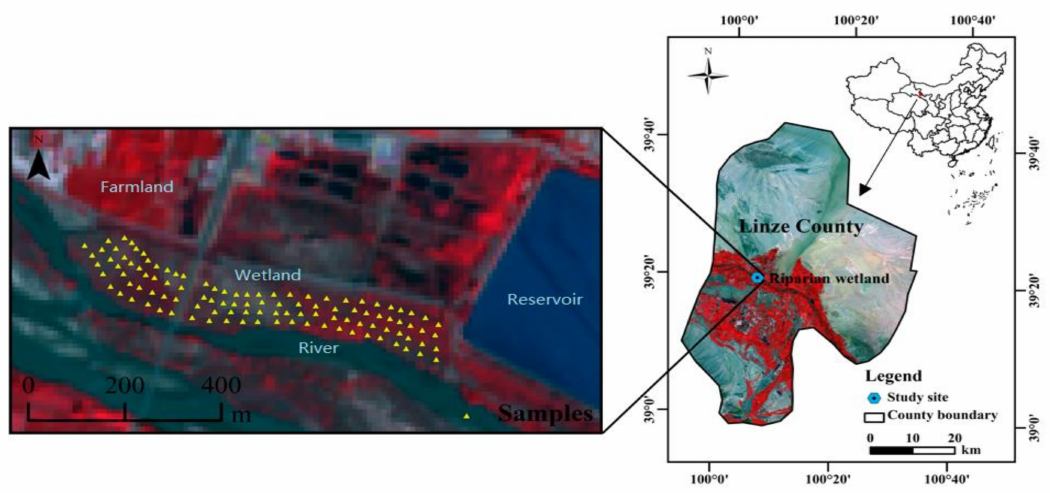
Figure 1. Map showing location of the study site, a typical riparian wetland in an arid zone in northwestern China. Triangles indicate sampling